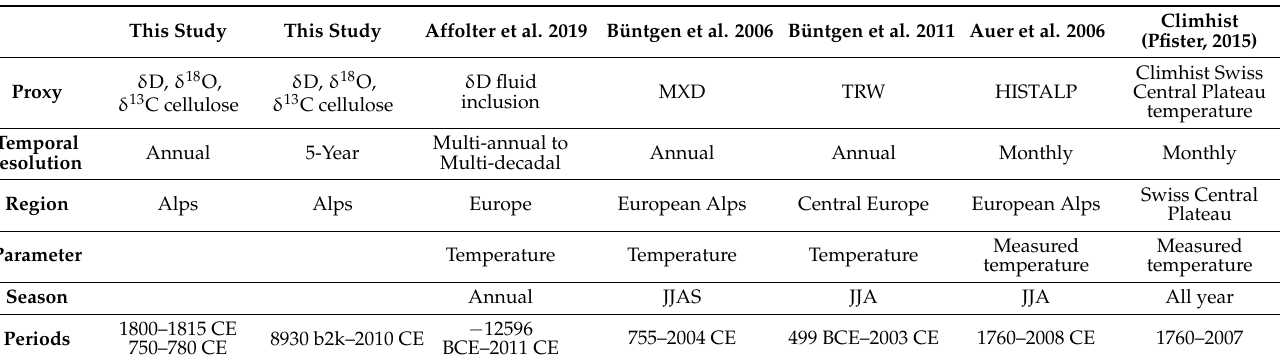
Table 1. Comparison of our database with other paleoclimatic temperature reconstructions and temperature